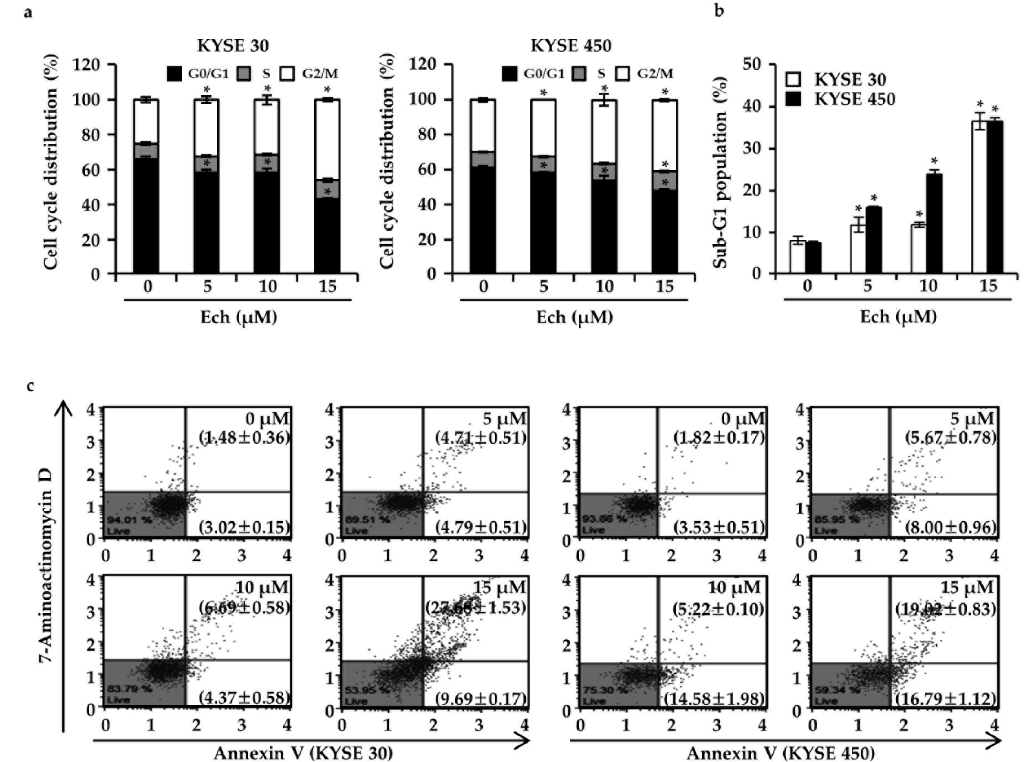
Figure 2. Effects of Ech on cell cycles and apoptosis. ( a ) Ech arrested G2/M phase of cell cycle and ( b ) induced sub-G1 population in KYSE 30 and KYSE 450 cells. ( c ) Ech increased apoptotic population of KYSE 30 and KYSE 450 cells. Viable cells (Annexin V negative/7-AAD negative) are shown in the lower left; Early apoptotic cells (Annexin V positive/7-AAD negative) are shown in the lower right; Late apoptotic cells (Annexin V positive/7-AAD positive) are shown in the upper right; Necrotic cells (Annexin V negative/7-AAD positive) are shown in the upper left. Cells were treated with Ech at 0, 5, 10, or 15 µM for 48 h, stained with 7-AAD for the cell cycle or Annexin V/7-AAD for apoptosis, and analyzed with Muse™ Cell Analyzer. Asterisk (*) denotes p < 0.05 compared to the control.